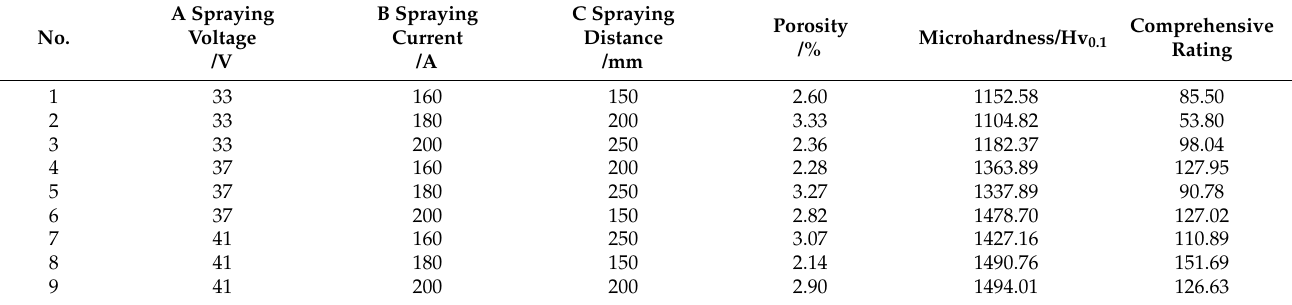
Table 4. Orthogonal test